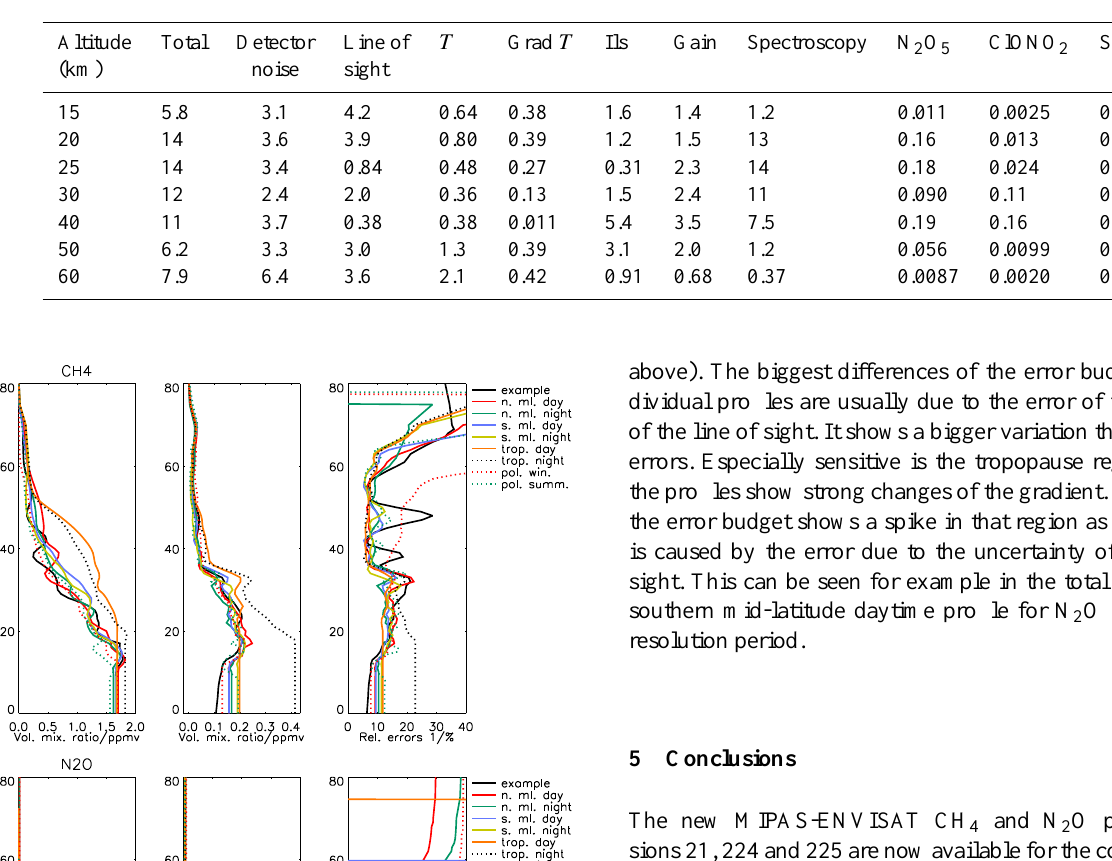
Table 2. Error budget for CH 4 for the measurement in orbit 43202 at 39.4 ◦ N, 78.9 ◦ E on 5 June 2010, 05:02:29UTC (derived from reduced- resolution spectra, version V5R_CH4_224). Relative values are given as percentages.